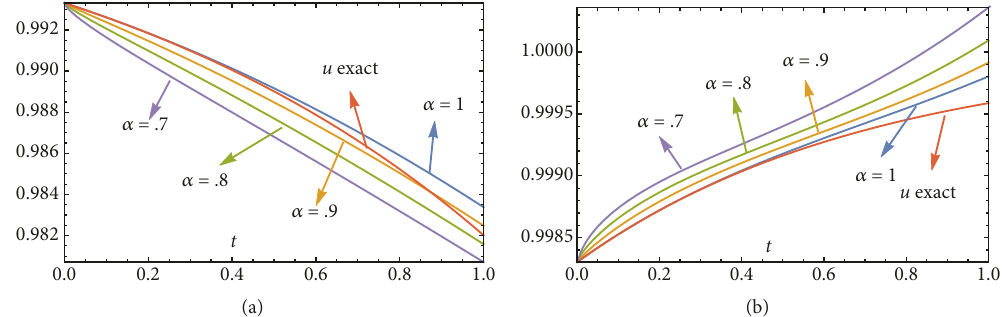
Figure 2: (a) Fractional Gardner equation at 𝑥 = 5,𝜀 = 1 . (b) Fractional Chan-Hilliard equation at 𝑥 = 5 .